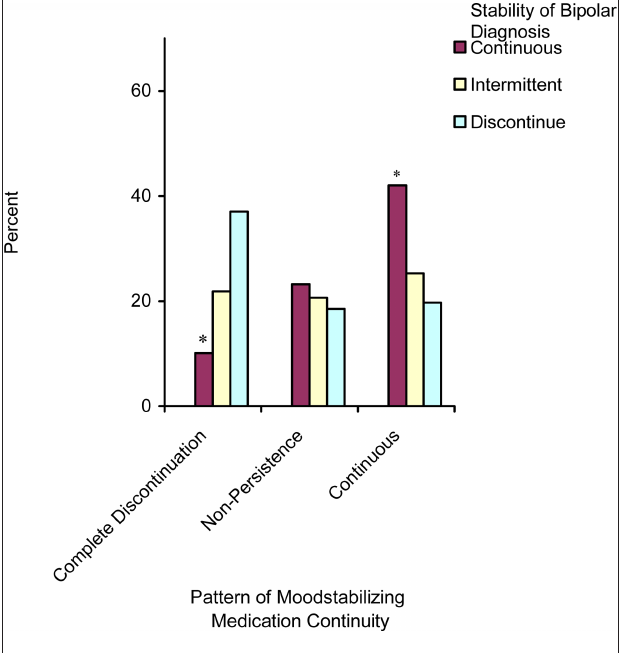
0.05).FIgURe 2 | Continuity of mood stabilizing medications by stability of bipolar diagnosis – only including those who ever initiate ( n = 239, * p < 0.05).